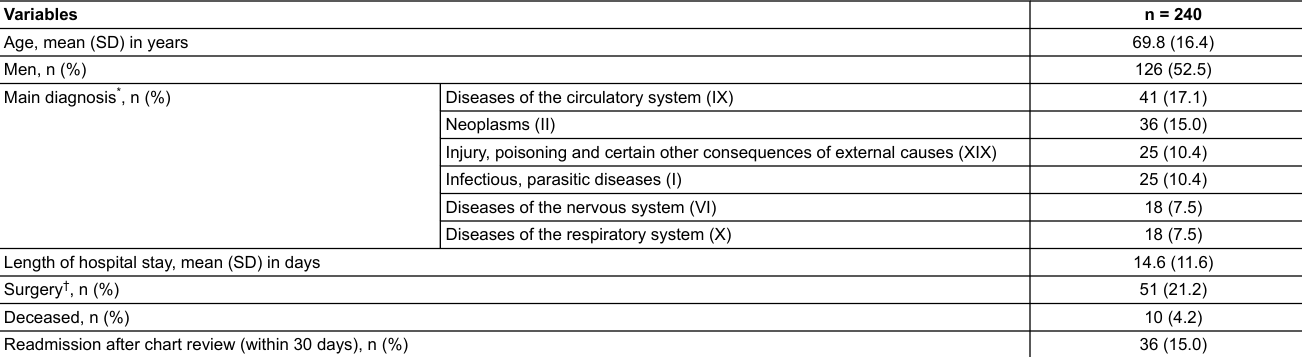
Table 1: Characteristics of the patients included in the GTT screening process.